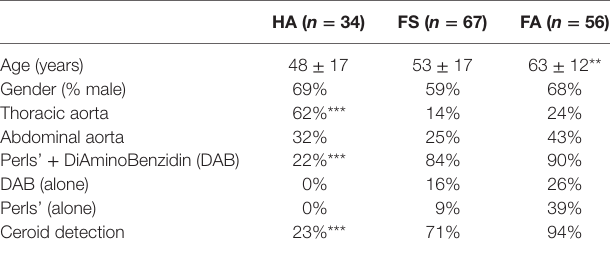
TaBle 2 | Stages of early lesions in the thoracic and abdominal aortas according to subject age and gender.